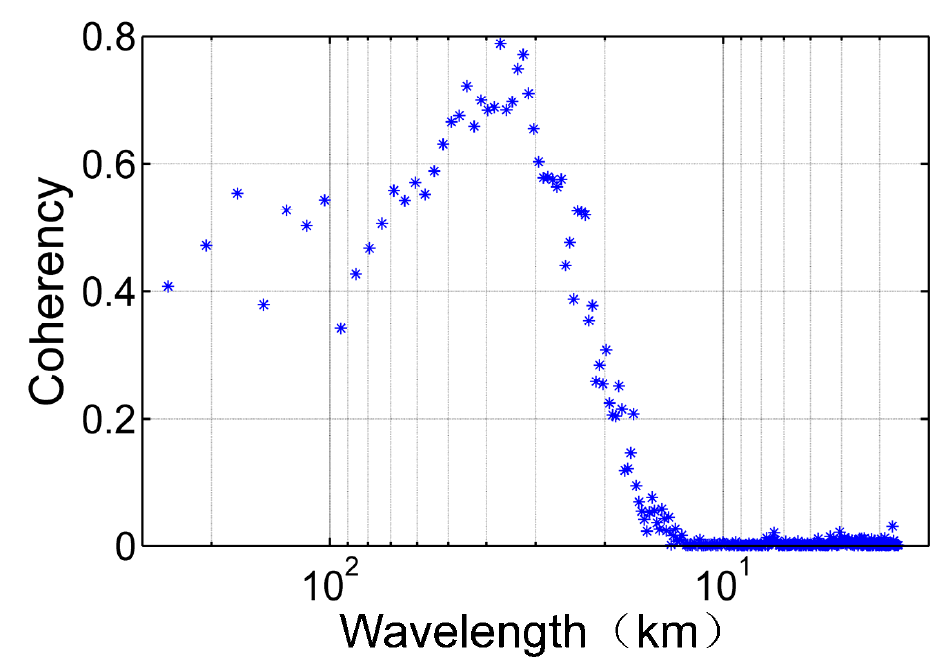
Figure 4. Results of the coherency between the gravity anomaly and seafloor topography changing with wavelength.